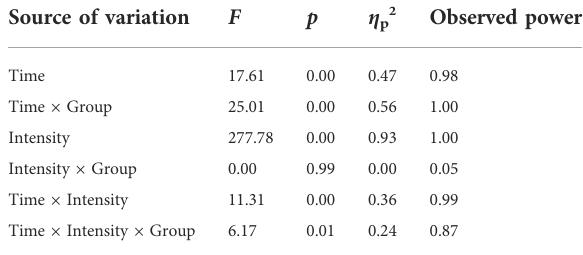
TABLE 3 Three-way repeated measures ANOVA for subjects in different groups and test situations at different levels of running